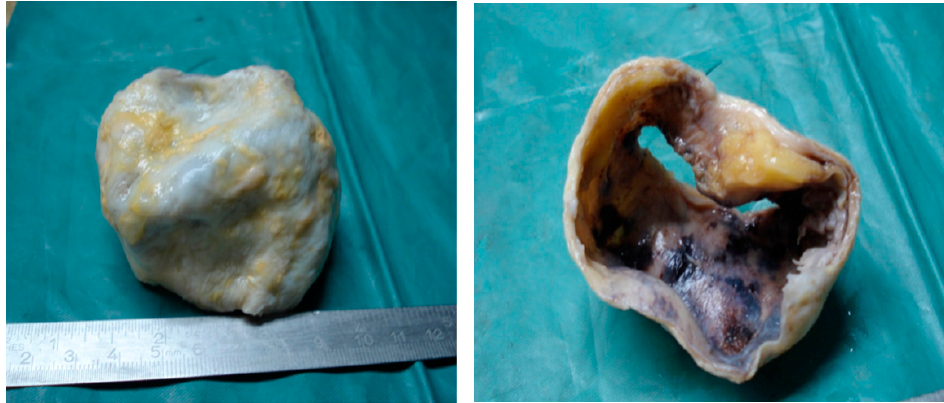
Figure 4. The resection piece—an ascending aortic aneurysm with a diameter of 5 cm. Figure 4 . The resection piece—an ascending aortic aneurysm with a diameter of 5 cm. 5a).